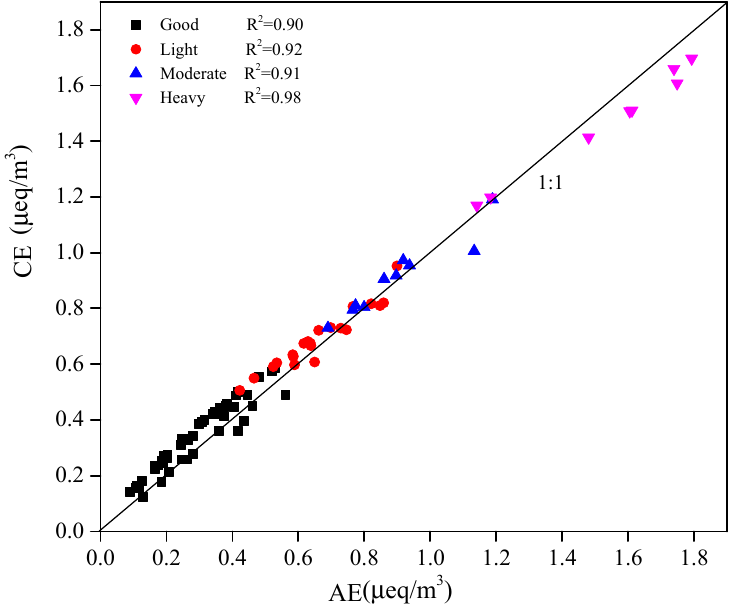
Figure 4. Scatter plots between RH and NOR ( a ), SOR ( b ), temperature and NOR ( d ), SOR ( e ), and the correlations of temperature and RH against SOR ( c ) and NOR ( f ) in sampling period.